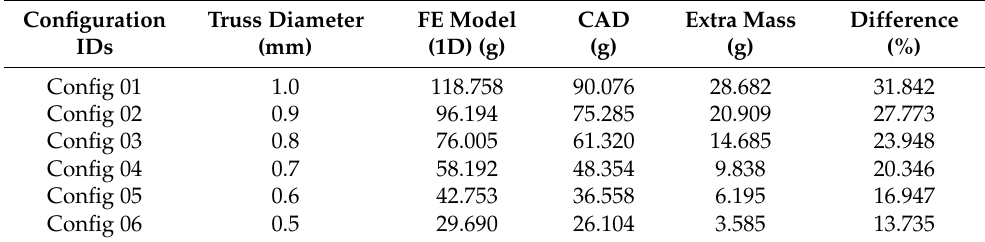
Table 3. Total Mass for 1D-FE and CAD models.